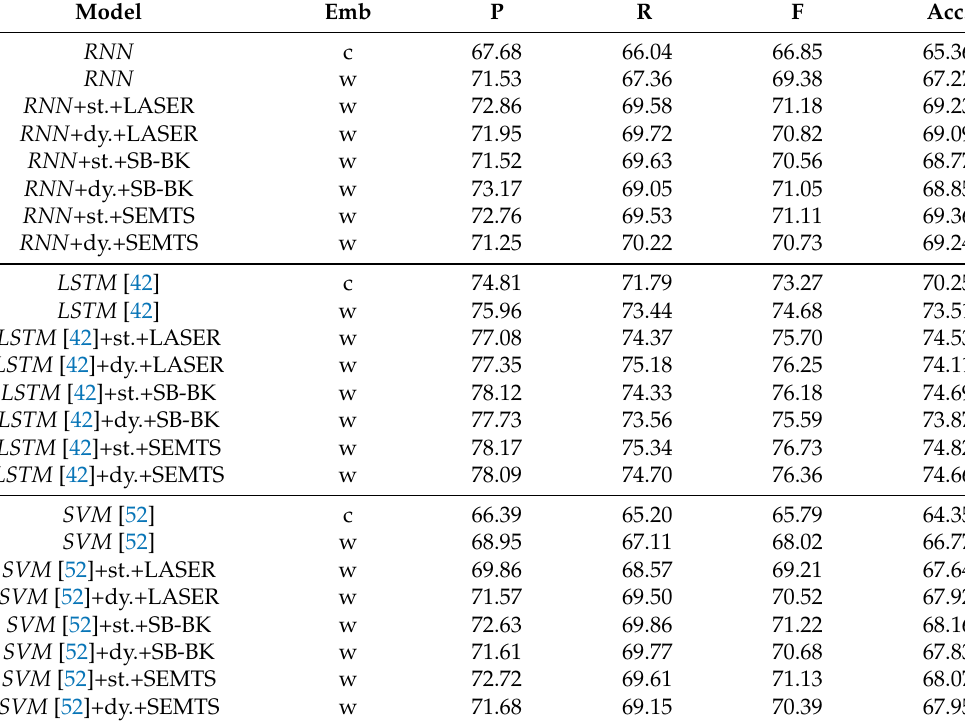
Table A2. The evaluation results of other methods on BQ. 1L-MLP stands for a one-layer MLP, LR stands for logistic regression [51], and DCNN stands for a dynamic convolutional neural network with k-max pooling [47]. When SVM, MLP, and LR are used for evaluation, the sentence representation is obtained by implementing average pooling transformation on the variable-length word (character) embedding